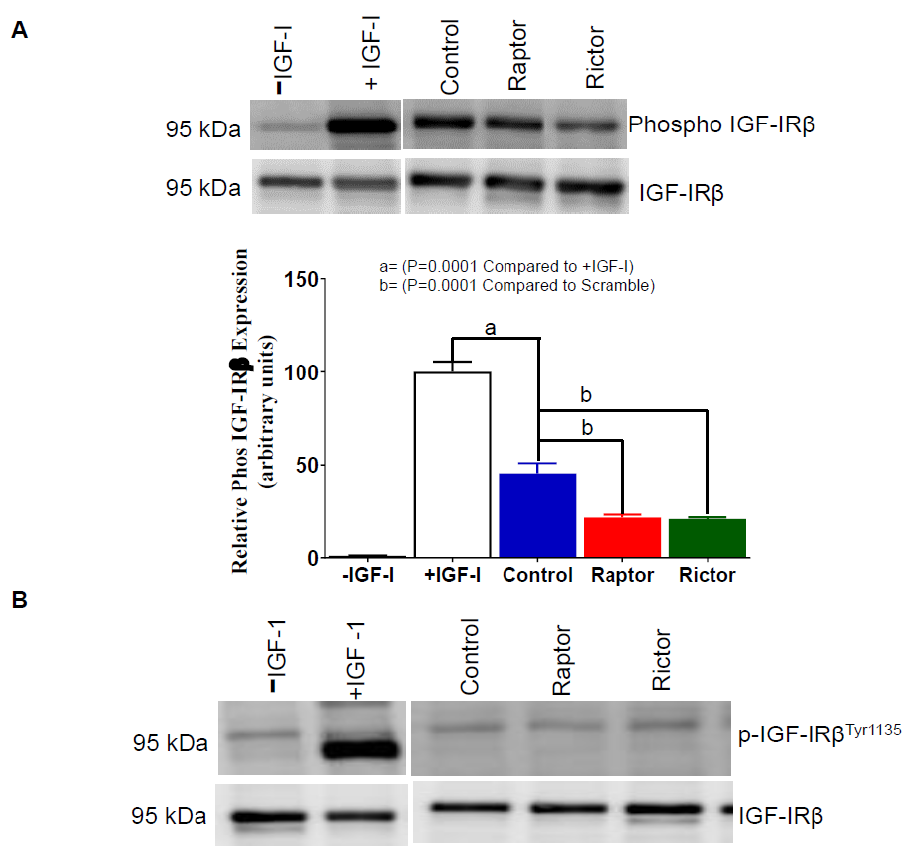
Figure 6. Inhibition of IGF-1R autophosphorylation in P6 cells using CM from HepG2 Cells treated with CM from PHT cells with RAPTOR and RICTOR siRNA. The ability of IGFBP-1 secreted from HepG2 cells treated with CM from PHT cells with the control, RAPTOR, and RICTOR siRNA to inhibit IGF-1 receptor autophosphorylation in P6 cells. ( A ) An equal amount of P6 cell lysate protein (25 µg) was loaded on 1-D gels for a Western blot using an antibody against p-IGF-1R β Tyr1135 . ( B ) Aliquots (1 mL) of HepG2 CM was used to treat a confluent culture of P6 cells in the absence of IGF-1 as a negative control while a serum-free sample containing 10 ng IGF-1 was a positive control. An equal protein amount (25 µg) of treated P6 cell lysate was loaded on 1-D gels for a Western blot using an anti-p-IGF-1R β antibody. The membranes were then stripped and re-probed with a total IGF-1R β antibody. The data were represented normalized to the control with Mean + SEM, analyzed with a one-way ANOVA, and corrected with a Bonferroni multiple comparison test. Means without a common letter differ are considered significant, p < 0.05.